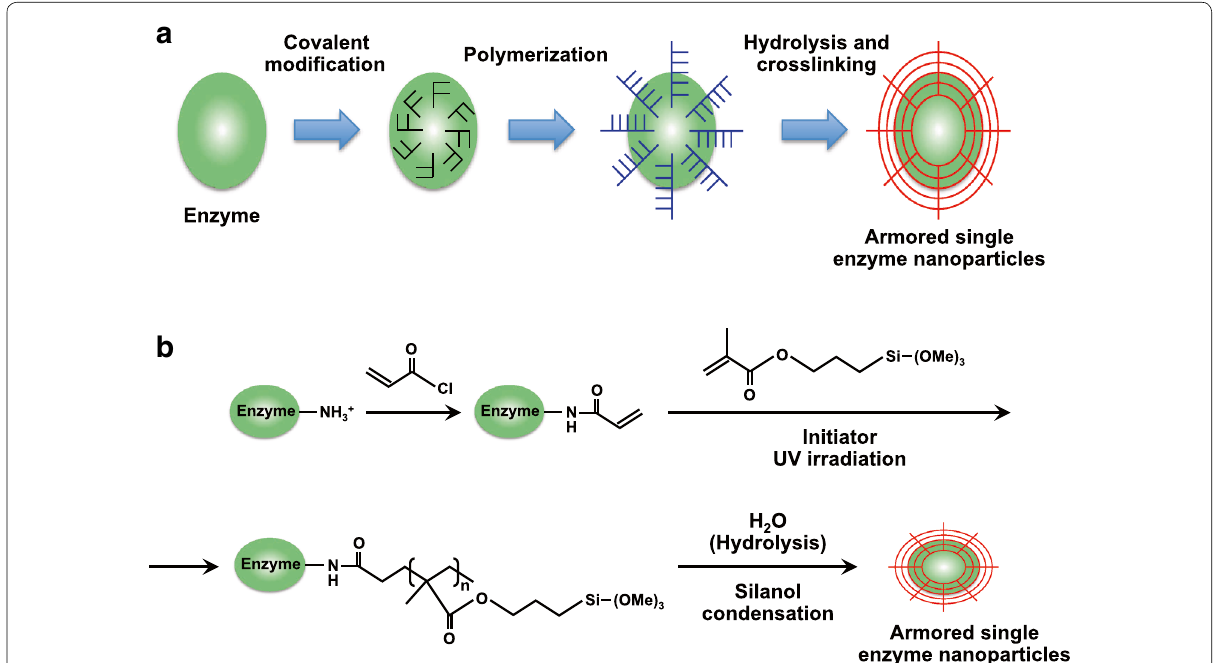
Fig. 9 Illustration of armored single-enzyme nanoparticle. a Schematic of preparation of the single-enzyme nanoparticles. b Chemistry for the synthesis of single-enzyme nanoparticles (Figure adapted with permission from Ref. [90]. Copyright (2003) American Chemical